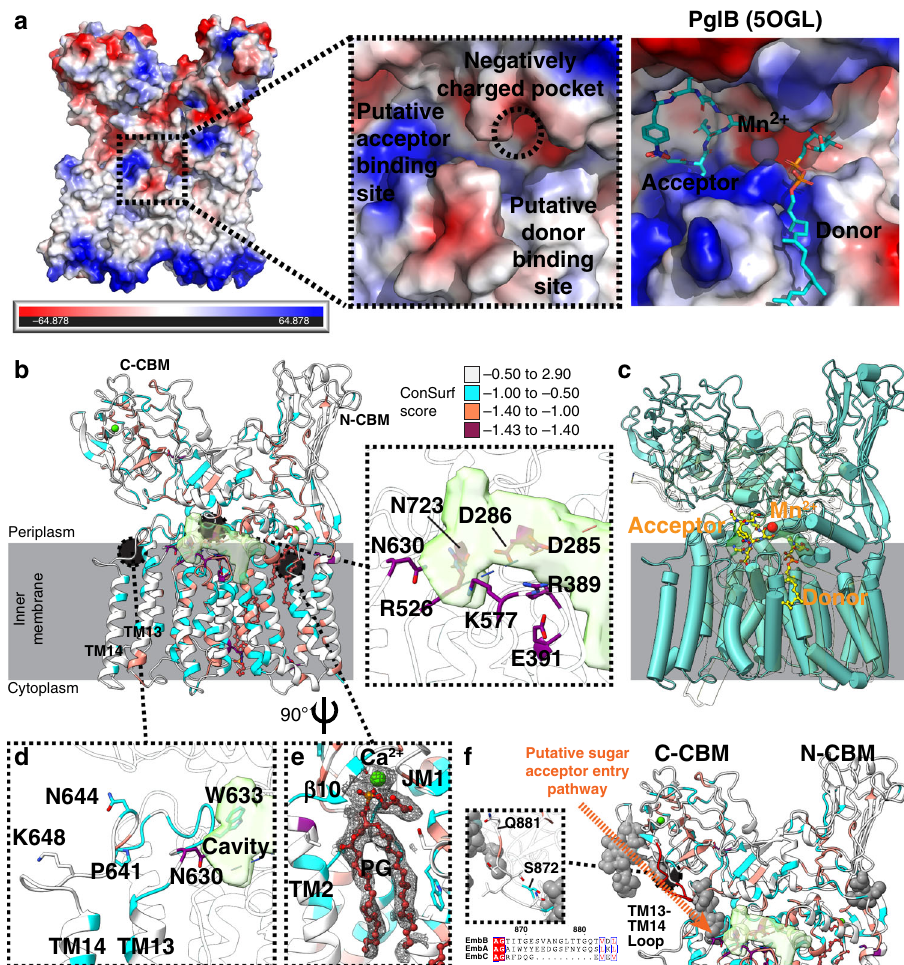
Fig. 2 Structural features of EmbB. a Electrostatic representation of EmbB, with a zoom-in around the putative active site, labeled according to where the substrates are likely to bind, where red is more negatively charged and blue more positively charged. A comparison with the PglB active site with bound substrates is also shown, after PglB was aligned against EmbB. b Structure of EmbB, rendered in cartoon and colored based on ConSurf 69 score for sequence conservation. The more negative the score, the more conserved the residue. The putative active site cavity, generated by the Voss Volume Voxelator server 68 is colored in semi-transparent green. The insert shows the putative active site cavity with the strictly conserved residues labeled. c EmbB (pale blue) is superimposed on PglB (semi-transparent yellow), with the ligands and Mn 2 + ion of PglB shown in yellow as sticks and a ball, respectively. d Residues that are known to maintain catalytic activity while altering substrate speci fi city on a loop between TM13 and TM14 are labeled and side chains are shown. e A tightly bound phosphatidylglycerol (PG shown as ball-and-stick) and calcium ion (shown as a ball) in a pocket between TM2, JM1, and β 10 is shown. The density map of the lipid and the ion is displayed as mesh. f Glycan ligands for the top ten Dali server hits for both N-CBM and C-CBM were mapped onto the structure as a gray ball representation. 2WJS [10.2210/pdb2WJS/pdb] (PDB ID) was used for N-CBM, while 3PTY [10.2210/pdb3PTY/pdb] and 4GWM [10.2210/pdb4GWM/pdb] were used for the C-CBM. The missing loop in EmbC is colored in red, and the insert is a zoomed-in view. Sequence alignment of the region around the loop is appended below the insert. The putative sugar acceptor entry pathway is shown as an orange dotted